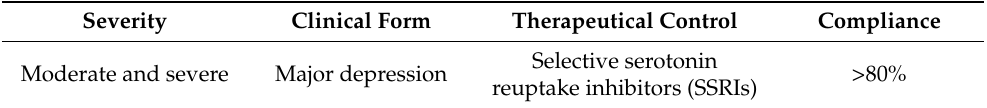
Table 1. Characterization of depression